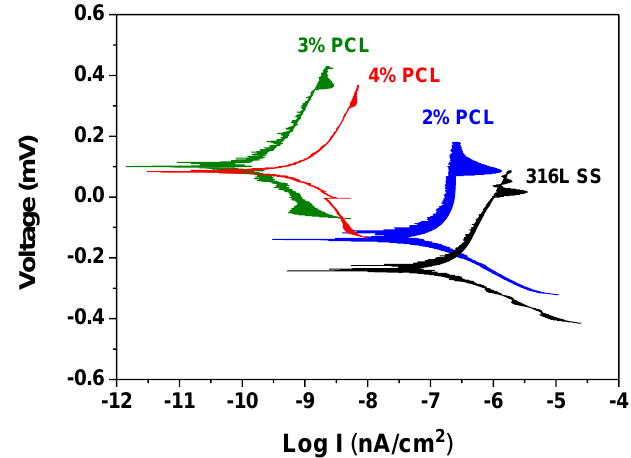
Figure 2. The water contact angles of the bare 316L SS and the 316L SS coated with 2, 3, and 4% PCL films.